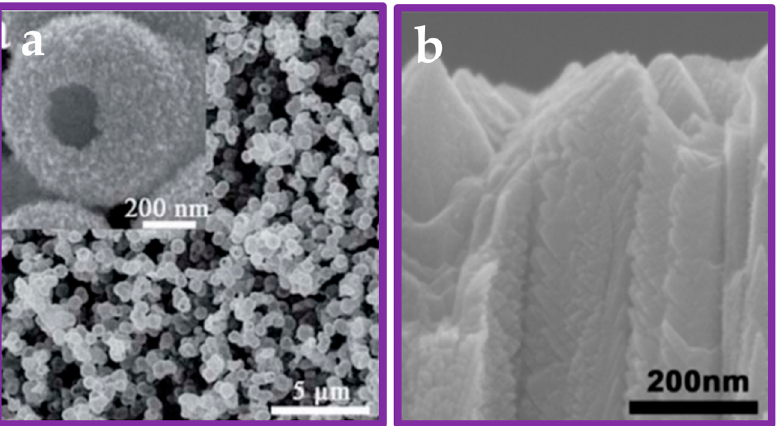
Figure 6. ( a ) SEM images of the stable mesoporous black TiO 2 hollow spheres [30]. Reprinted with permission from ref. [30]. ( b ). Lateral view of high-resolution SEM images of the TiO 2 catalyst prepared [9]. Reprinted with permission from ref. [9].